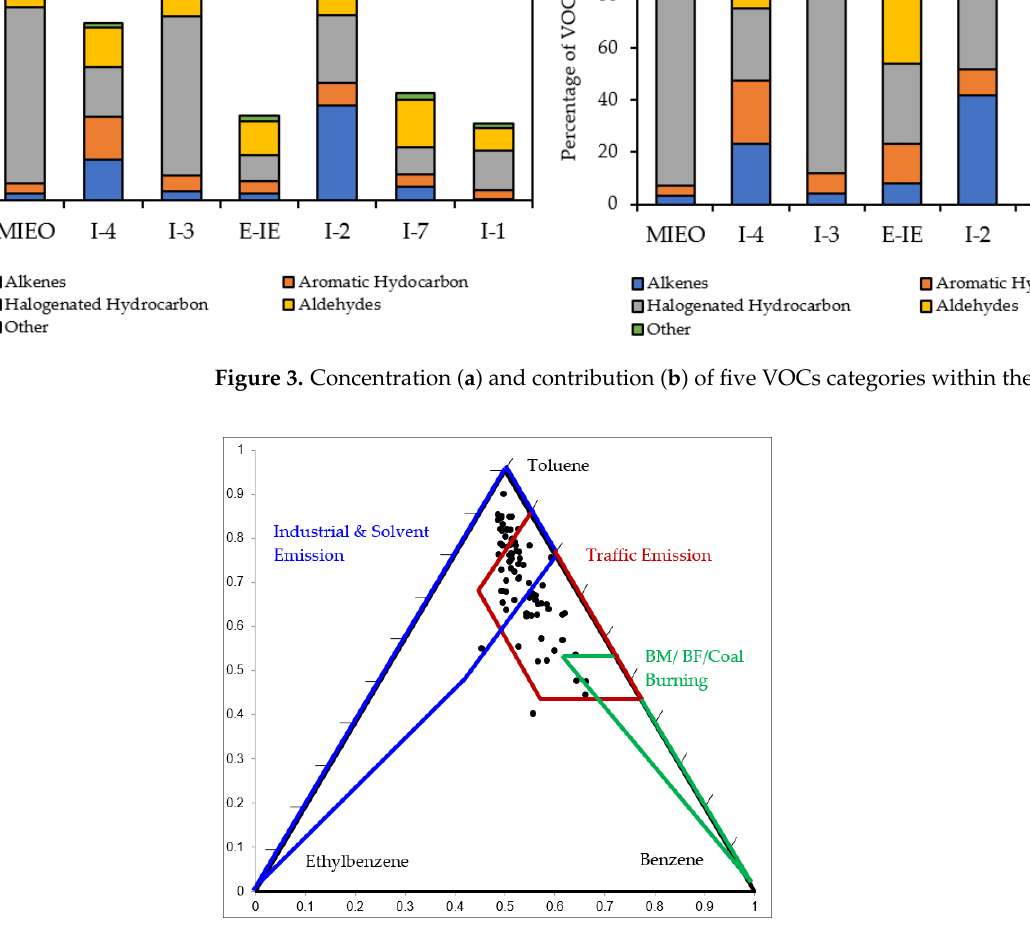
Figure 4. B/T/E ratios at the HMTP monitoring station.